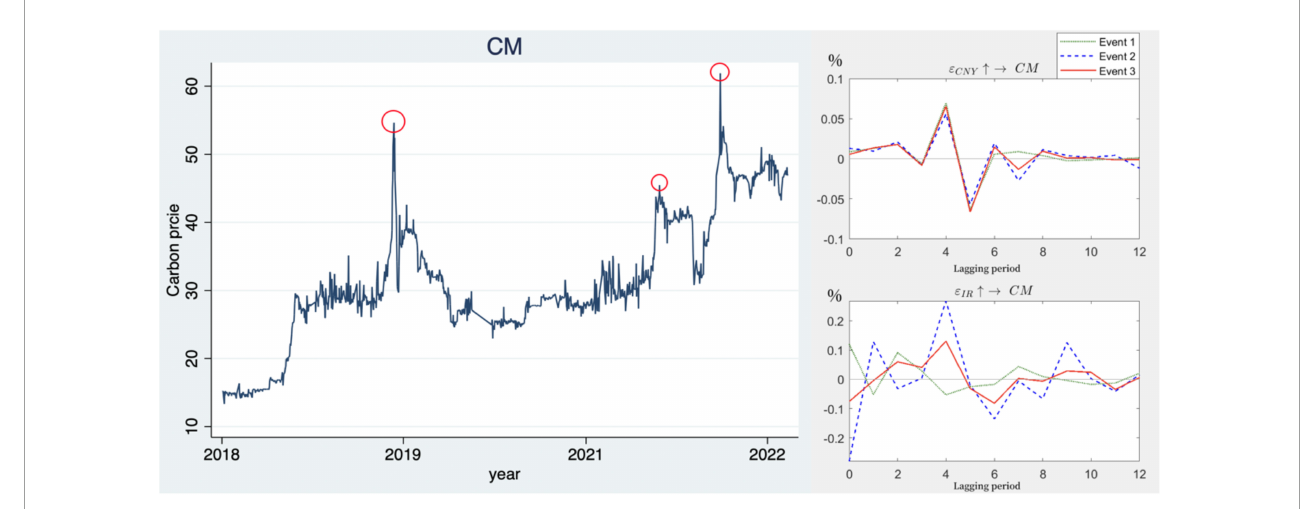
FIGURE5 Impulse response at different points in